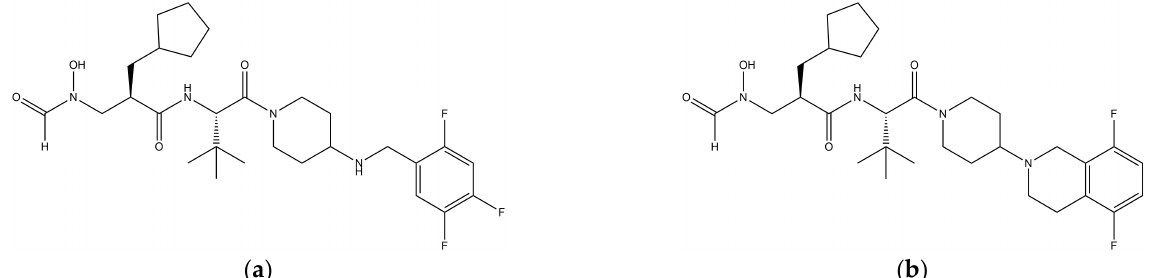
Figure 1. Chemical structure of ( a ) IDP-73152 (C28H41F3N4O4, Mw of 554) and ( b ) internal standard (i.e., IDP-117293; C30H44F2N4O4, Mw of 562).